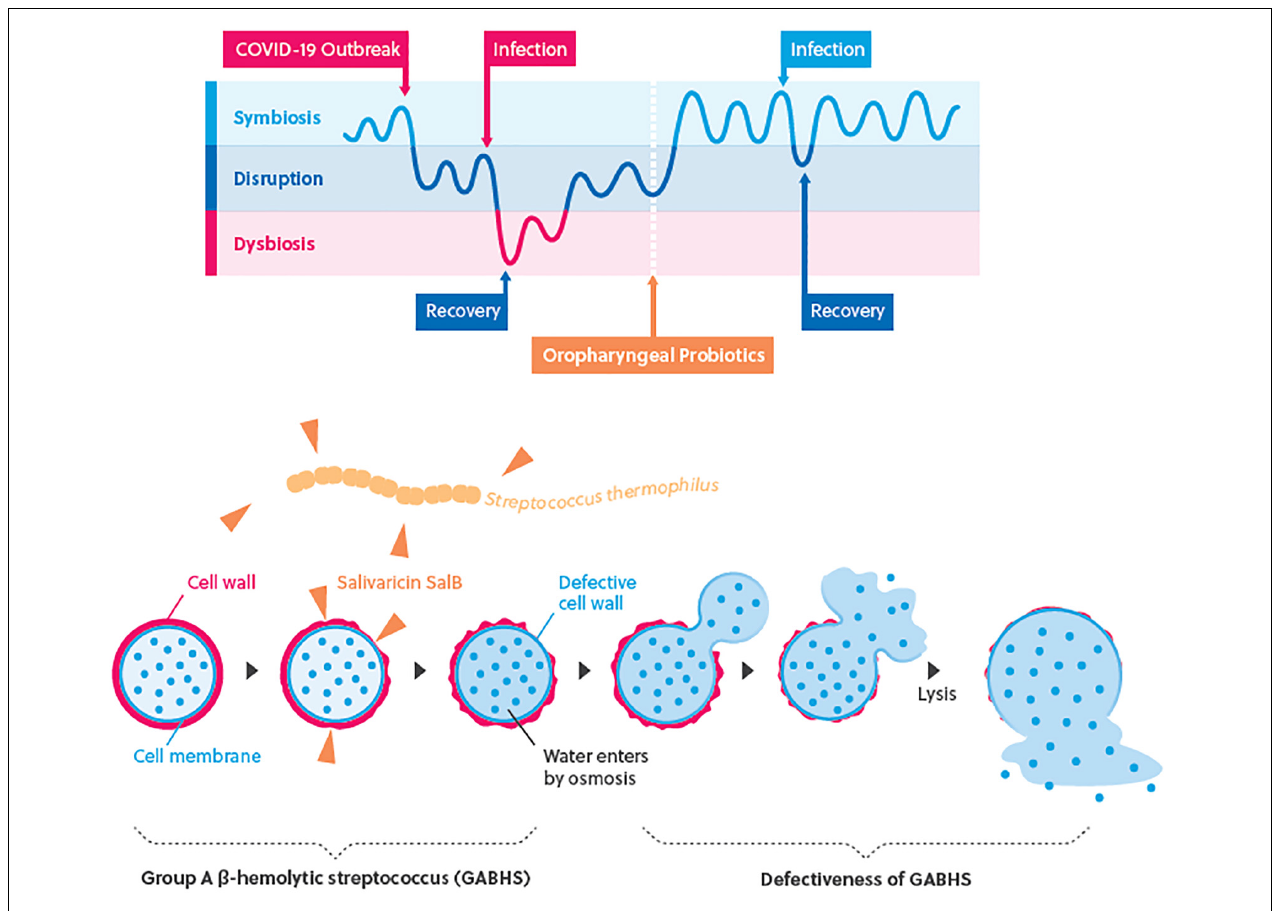
FIGURE 2 | The hypothetical graph of interactions of host oropharyngeal microflora and immune